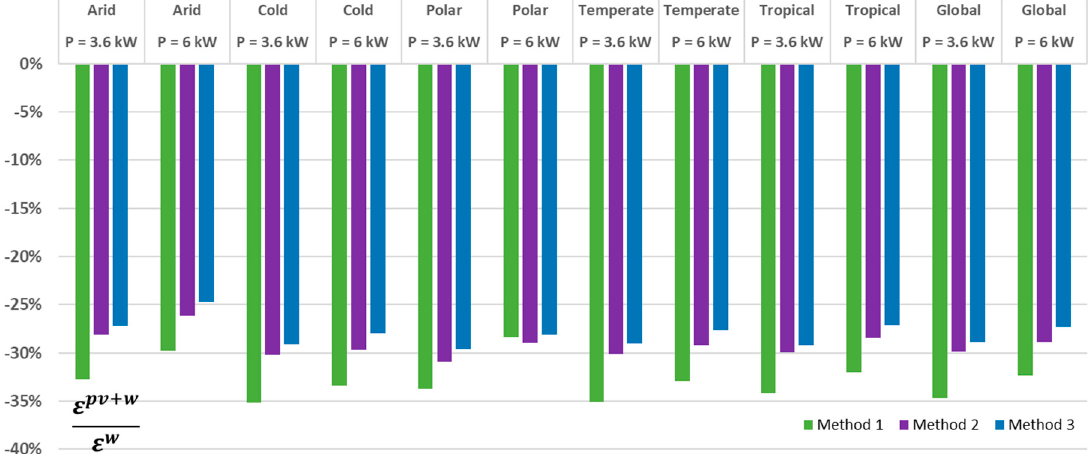
Figure 17. Improvement of the matching factor: ε pv+w (hybrid) over ε w (wind) facilities for different installed power capacity.